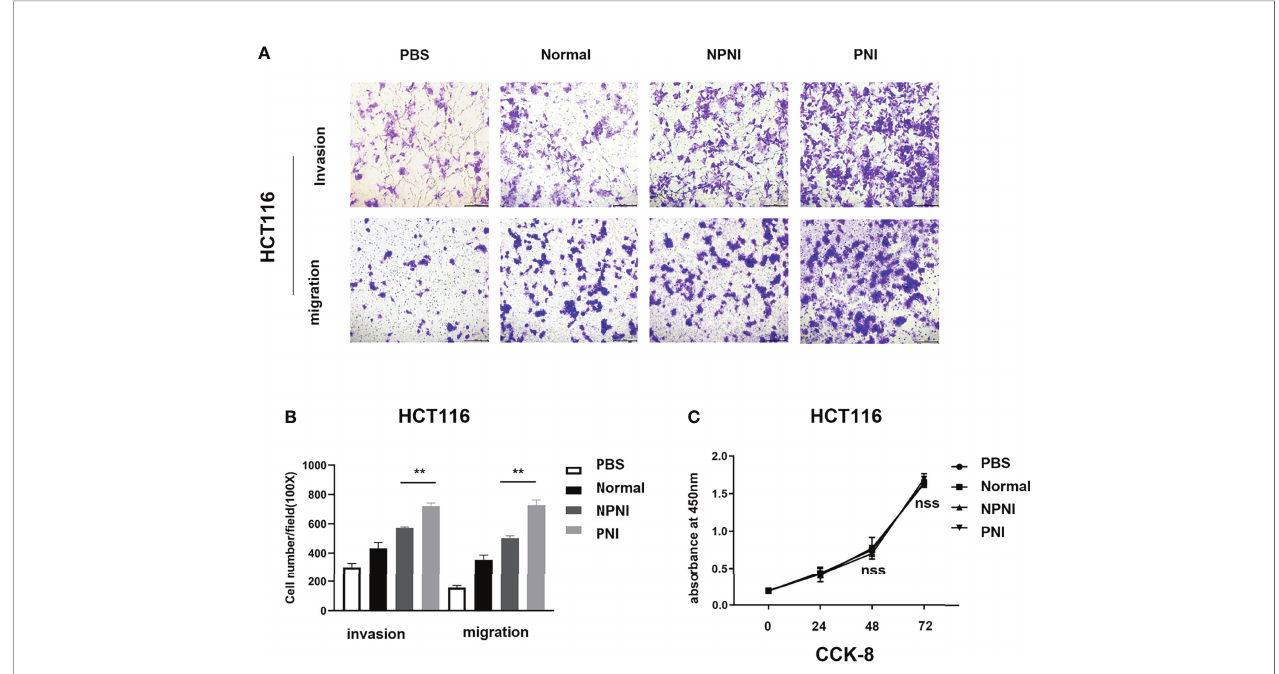
FIGURE 5 | EVs derived from CRC patients with PNI promote CRC cell migration and invasion. (A, B) Transwell assays were used to determine the invasion and migration of HCT116 cells treated with EVs (175 m g) from CRC patients with PNI, CRC patients without PNI, or EVs from normal controls; PBS was used as a blank control. (C) Cell Counting Kit-8 assay of HCT116 cell proliferation following treatment with serum EVs derived from CRC patients with PNI, CRC patients without PNI, and normal controls. ** P < 0.01, nss, P > 0.05 (Student ’ s t